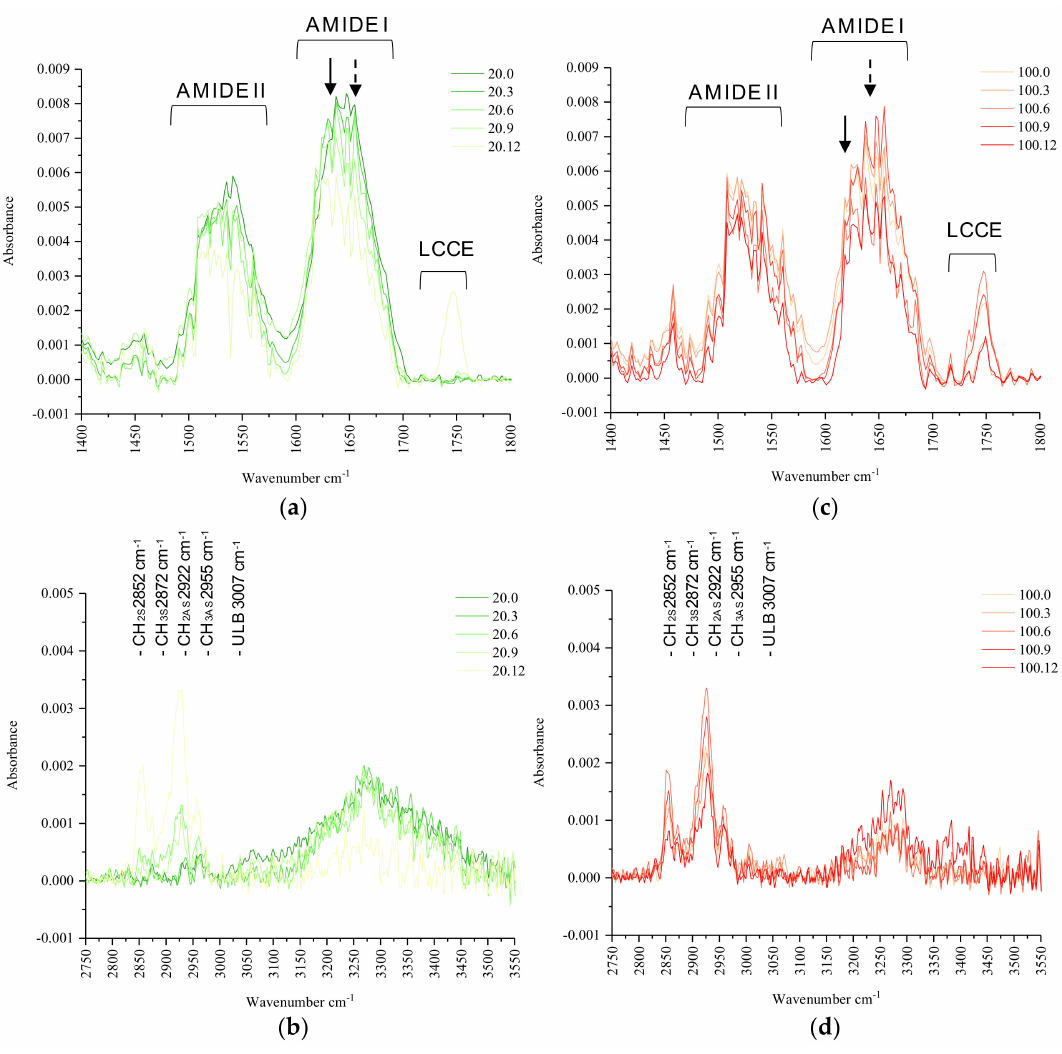
Figure A1. Total protein fingerprint region 1400–1800 cm − 1 ( a , c ) and lipid spectra ( b , d ) of canola meals produced at alternate barrel dry heat temperatures (20 ◦ C vs. 100 ◦ C) without or with moist heat pressure at increasing durations (0, 3, 6, 9 or 12 min). The α -helix (dashed arrow, 1652 cm − 1 ), β -sheet (arrow, 1630 cm − 1 ), amide II (ca. 1572–1480 cm − 1 ), amide I region (ca. 1714–1571 cm − 1 ), and lipid carbonyl C=O ester stretching band (LCCE, ca. 1789–1701 cm − 1 ), asymmetric CH 3 (CH 3AS ca. 2988–2951 cm − 1 with peak centre at ca. 2955 cm − 1 ), asymmetric CH 2 (CH 2AS ca. 2951–2882 cm − 1 with peak centre at ca. 2922 cm − 1 ), symmetric CH 3 (CH 3S ca. 2882–2868 cm − 1 with peak centre at ca. 2872 cm − 1 ) and symmetric CH 2 (CH 2S ca. 2868–2790 cm − 1 with peak centre at ca. 2852 cm − 1 ) functional groups in the attenuated total reflectance-Fourier transform infrared (ATR-FTIR) spectrum of canola meals. Spectra of a single representative replicate